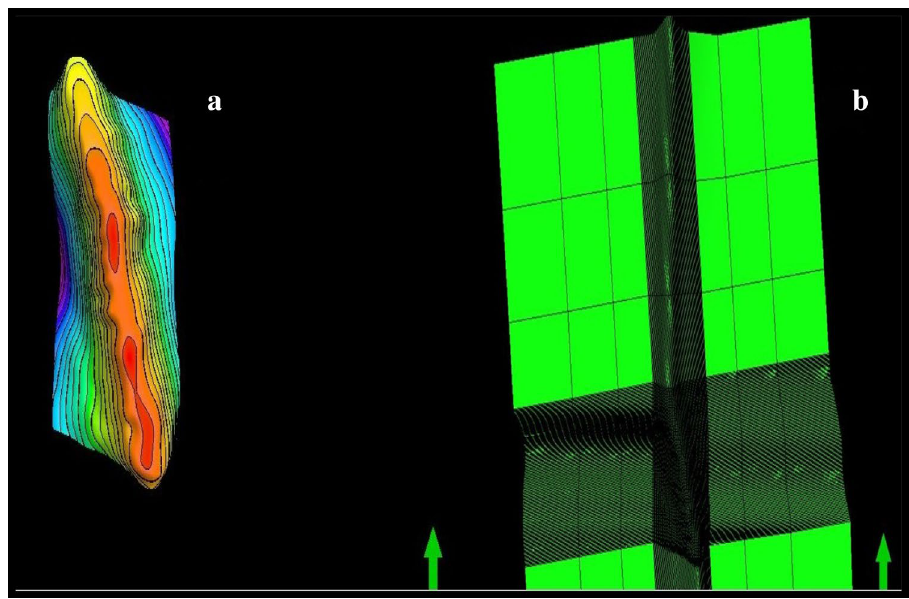
Fig. 11 Rotation angle of both reservoir and geomechanical grids